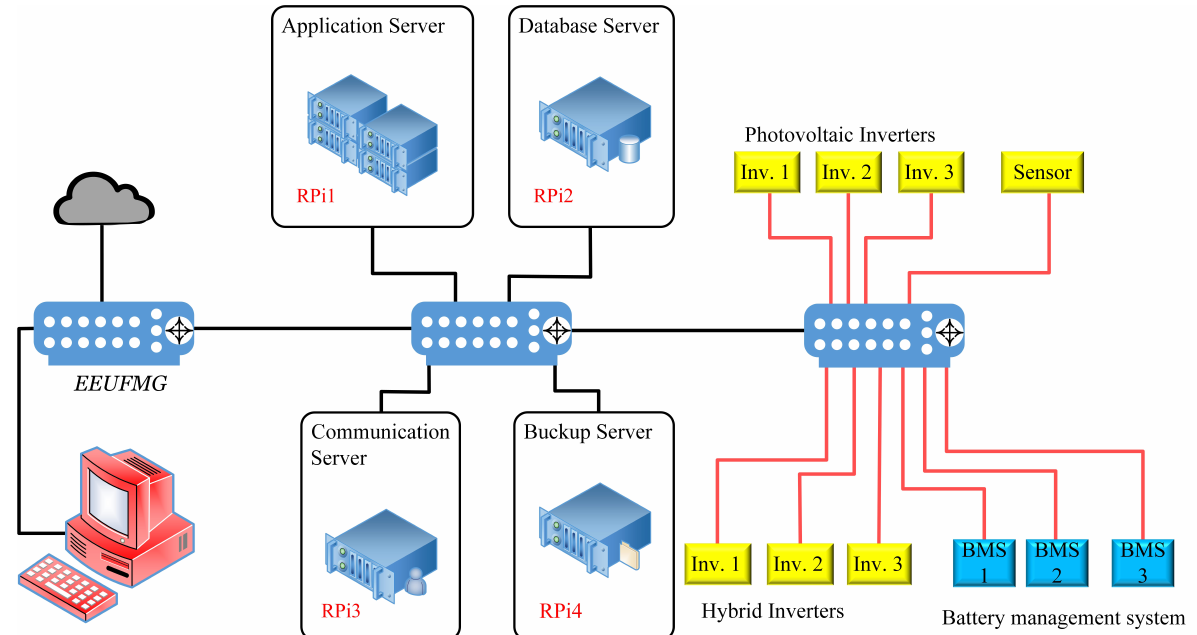
Figure 4. Schematic of the proposed server architecture for the supervisory system presenting the implemented system with the RPis (Raspberry Pi), inverters, and